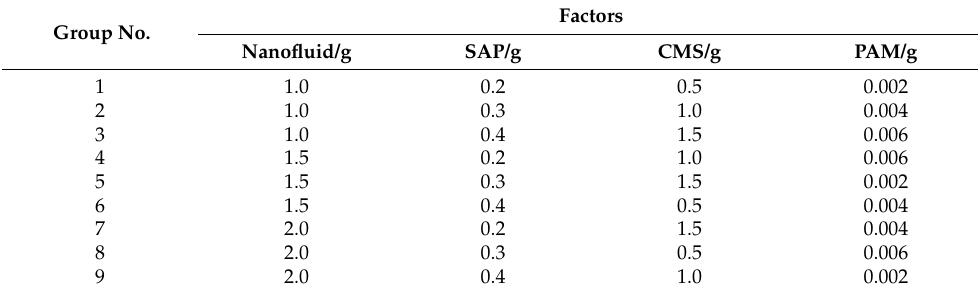
Table 1. Orthogonal experiment